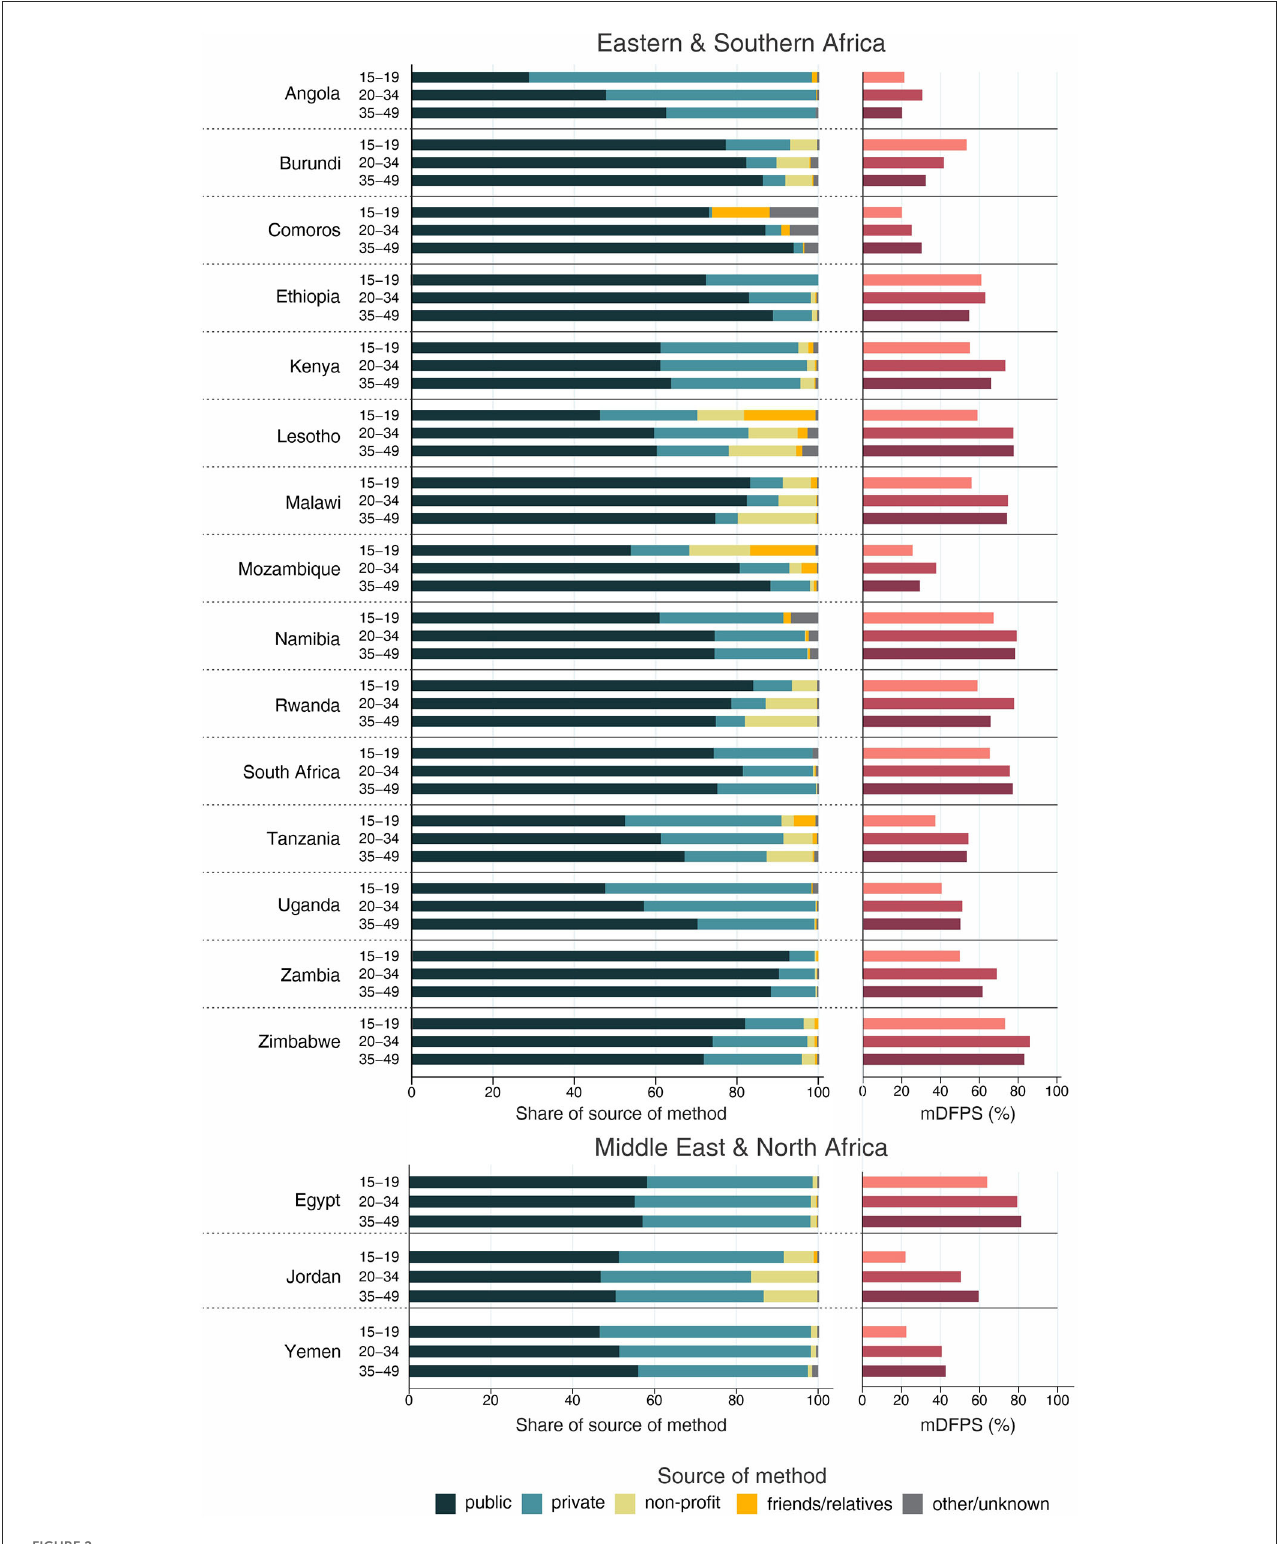
FIGURE2 Demand for family planning satisfied by modern methods (mDFPS) and share of source of method by women’s age in Eastern and Southern Africa and Middle East and North Africa. Source: DHS, 2010-2021.